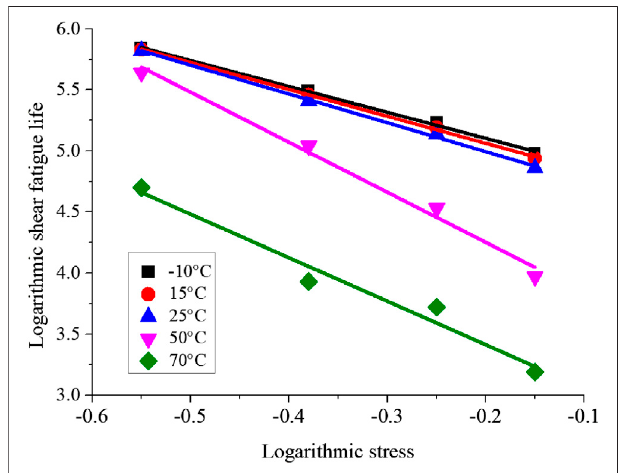
FIGURE 7 | Shear fatigue life diagram under a log – log